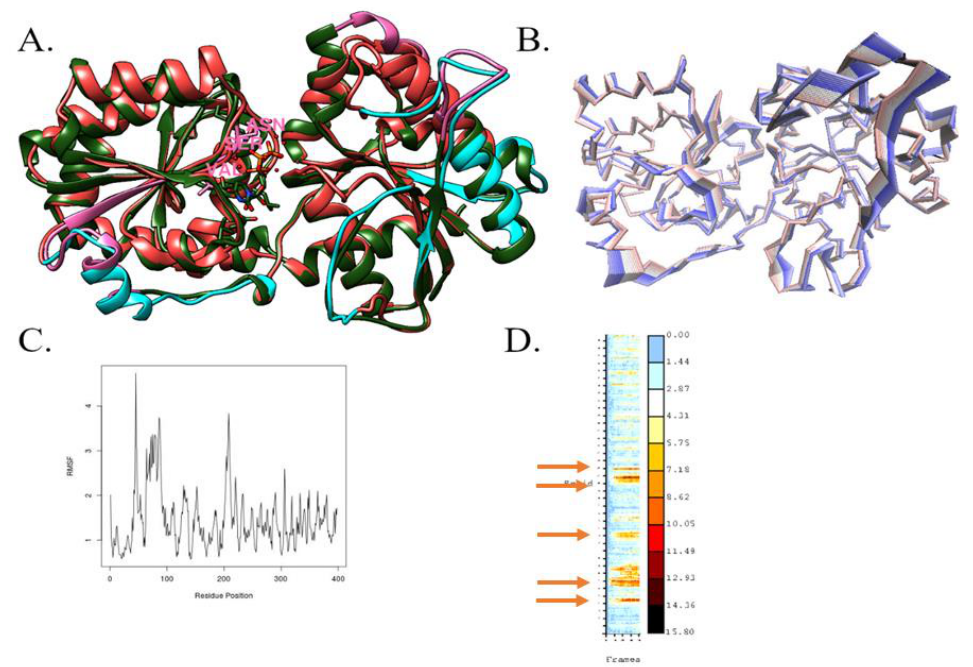
Figure 7. NmW-GT conformation changes. ( A ) RMSF analysis was conducted on MD trajectories and the regions showing highest conformational changes were highlighted with UCSF-Chimera in pink (BshA) and cyan (NmW-GT). The template (PDB ID: 6D9T) and the NmW-GT model were aligned with Matchmaker in UCSF-Chimera. ( B ) Segments with the highest flexibility in NmW-GT as revealed through principal component analysis (PCA). ( C ) Plot of the contributions of each residue to fluctuations of the NmW-GT. ( D ) Heatmap of the RMSD. The regions experiencing the highest mobility in NmW-GT are as follows: residues 42–48, 64–91, 128–136, 154–156, 201–214, and 219–223; gold arrows, also see Supplementary Figure S3.